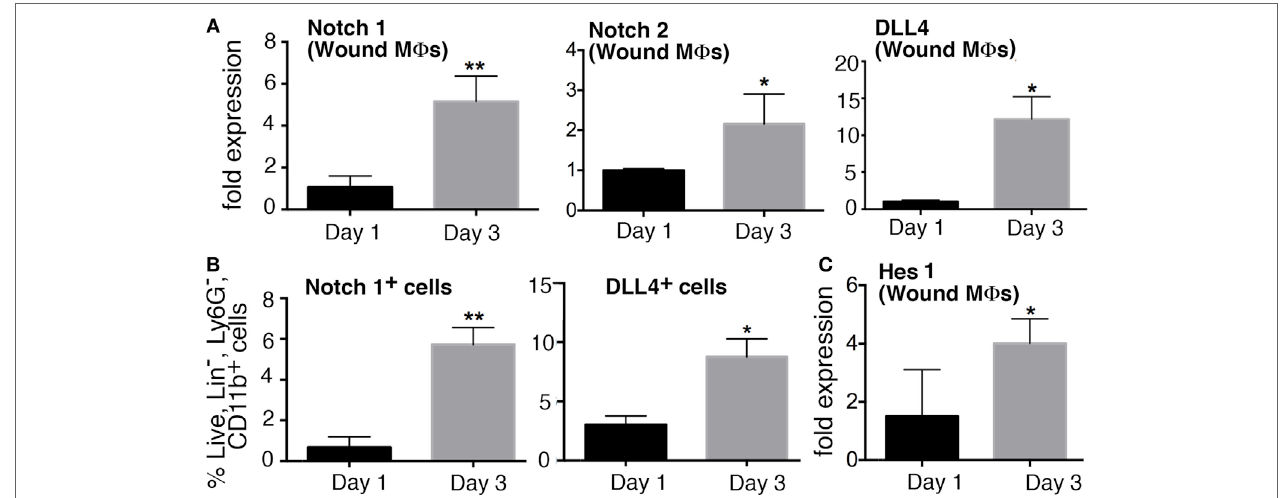
FigUre 1 | notch signaling is dynamic in macrophages during early wound healing . C57Bl/6 mice were wounded on the back using a 4 mm punch biopsy. Wounds were collected on days 1 and 3 post-wounding. (a) Wound macrophages (CD3 − /CD19 − /Ly6G − /CD11b + ) were isolated using magnetic-activated cell (MAC) sorting on days 1 and 3 post-wounding. Notch 1 receptor, Notch 2 receptor, and DLL4 ligand expression quantified by RT-PCR on days 1 and 3 ( n = 10 wounds in 5 mice/group; replicated 3 × ) (* P < 0.05; ** P < 0.01). (B) Flow cytometry quantification of Notch receptors/ligands in wounds on days 1 and 3. Notch 2 and DLL4 positive cells on days 1 and 3 expressed as a percent of live, lin − ,Ly6G − ,CD11b + cells ( n = 12 wounds in 6 mice/group; replicated 2 × ) (* P < 0.05; ** P < 0.01). (c) Hes1 gene expression was quantified by RT-PCR on days 1 and 3 ( n = 10 wounds in 5 mice/group; replicated 3 × ) (* P < 0.05). Statistical analysis was performed using two-tailed Student’s t -test. All data are expressed as mean ±